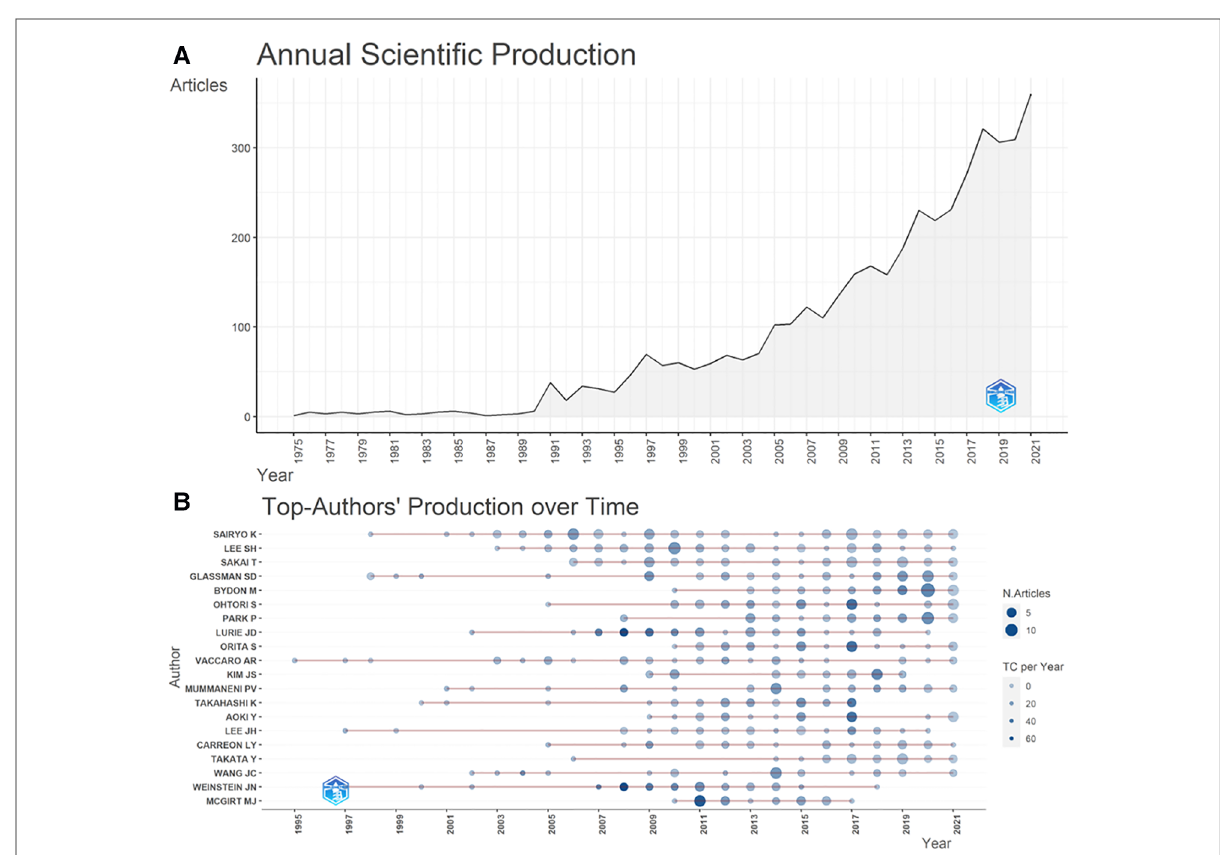
FIGURE 1 Annual publication production and the top-20 authors over time.